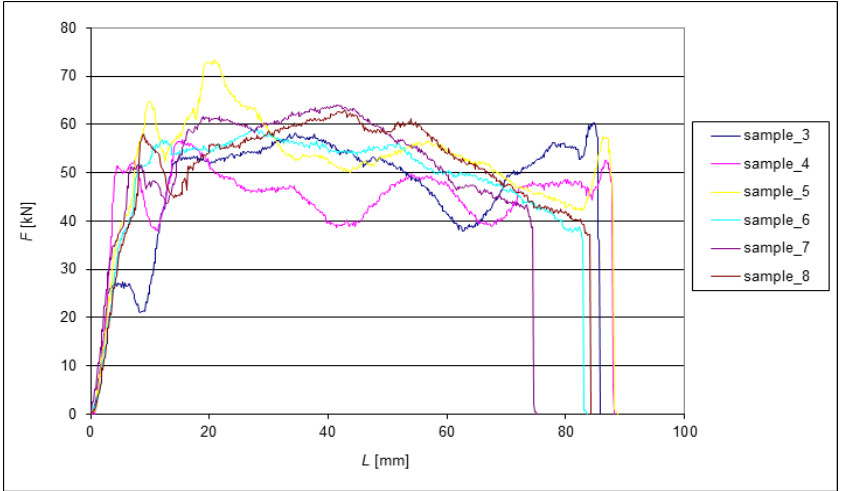
Figure 7. Dependence of the force on the length of extrusion during the second pass through the ECAP die.